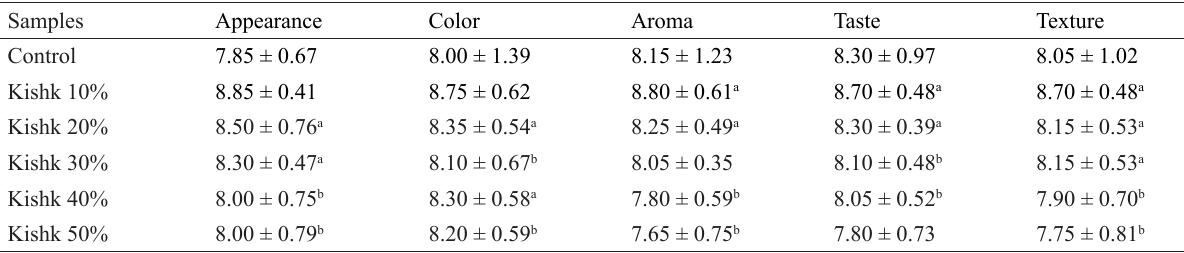
Table 6 Sensory scores of biscuits fortified with Egyptian kishk Samples